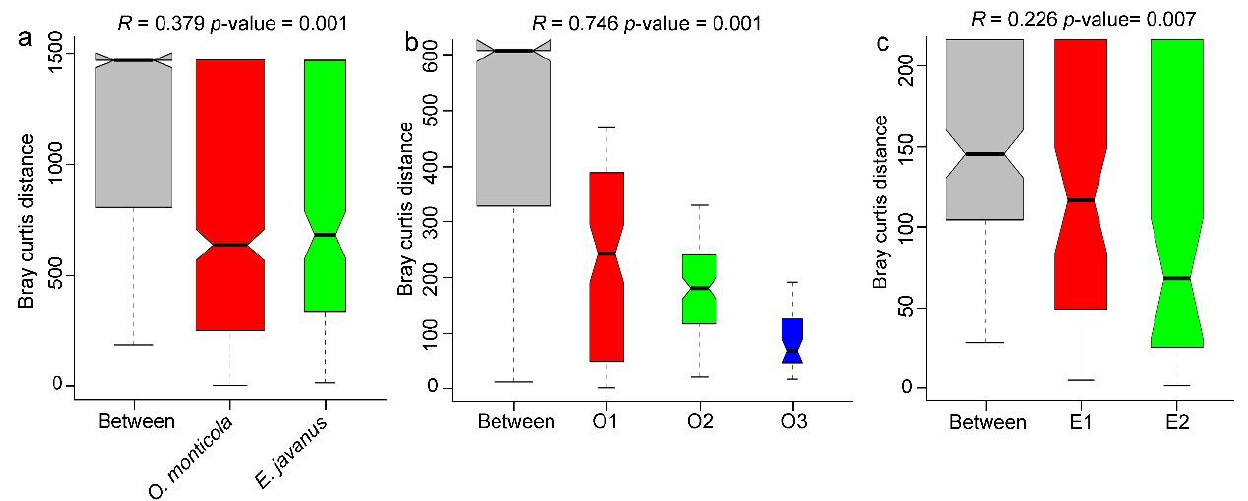
Figure 4. ANOSIM analysis presenting the similarity of bacterial communities among different groups. ( a ) Similarities of bacterial communities between O. monticola and E. javanus . ( b ) Similarities of bacterial communities across three colonies (O1, O2, and O3) of O. monticola . ( c ) Similarities of bacterial communities between two colonies (E1 and E2) of E. javanus .